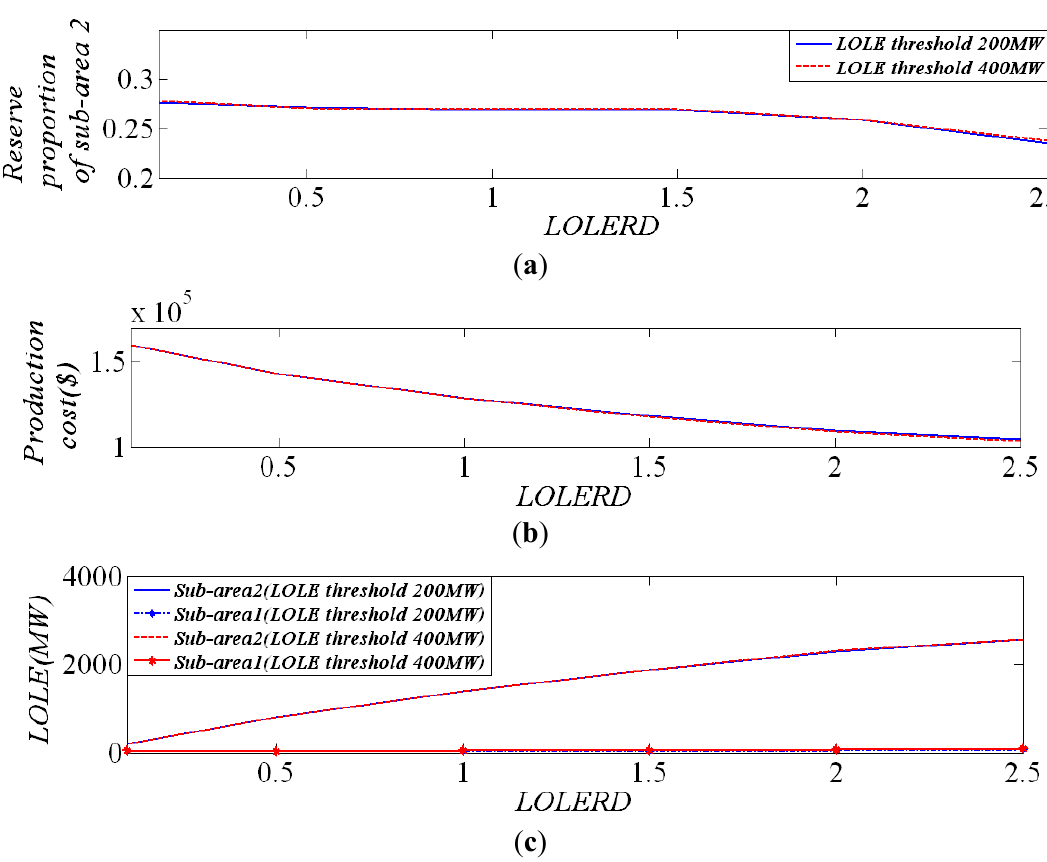
Figure 8. Results with different LOLE threshold. ( a ) Reserve allocation results of sub-area 2; ( b ) Production cost; ( c ) Relationship between subarea LOLE and